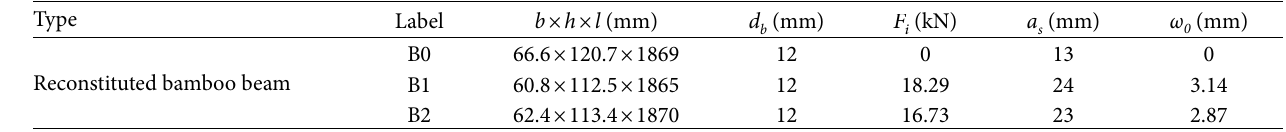
Table 3: Details of tested reconstituted bamboo beams applied with nonprestressed/prestressed BFRP bar.